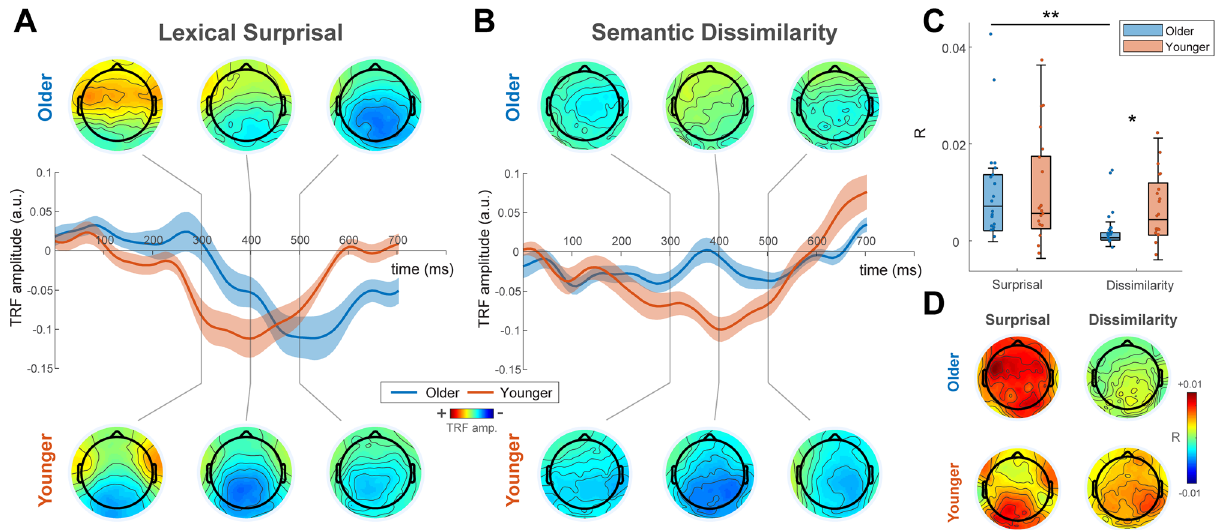
Figure 2. TRF weights. ( A ) Lexical surprisal TRF weights averaged over parietal electrodes and across older (blue) and younger (red) subjects. Shaded areas show s.e.m. across subjects. Scalp weight topographies at selected time windows (300 ms, 400 ms and 500 ms; window width of 50 ms) plotted above and below the channel plots for older and younger groups, respectively. N400 components were seen in the TRF weights at later time-lags for both groups and the peak latency of this component was significantly delayed for the older group. ( B ) Semantic dissimilarity TRF weights averaged over parietal electrodes and across older (blue) and younger (red) subjects. Shaded areas show s.e.m. across subjects. Scalp weight topographies at selected time windows (300 ms, 400 ms and 500 ms; window width of 50 ms) plotted above and below the channel plots for older and younger groups, respectively. In contrast to lexical surprisal, semantic dissimilarity TRF weights were significantly weaker at later time lags for the older group compared to the younger group. ( C ) EEG Prediction Accuracy. Boxplots of EEG prediction accuracy corresponding to each linguistic feature (lexical surprisal and semantic dissimilarity) and age-group. Dots indicate individual subjects. Consistent with the feature weights of the TRF, there were no significant differences between the prediction accuracies for dissimilarity and surprisal over parietal channels for younger subjects. However, older subjects showed significantly higher prediction accuracy for surprisal compared to dissimilarity at these channels. ( D ) Topographical plots of prediction accuracy for both age groups and both